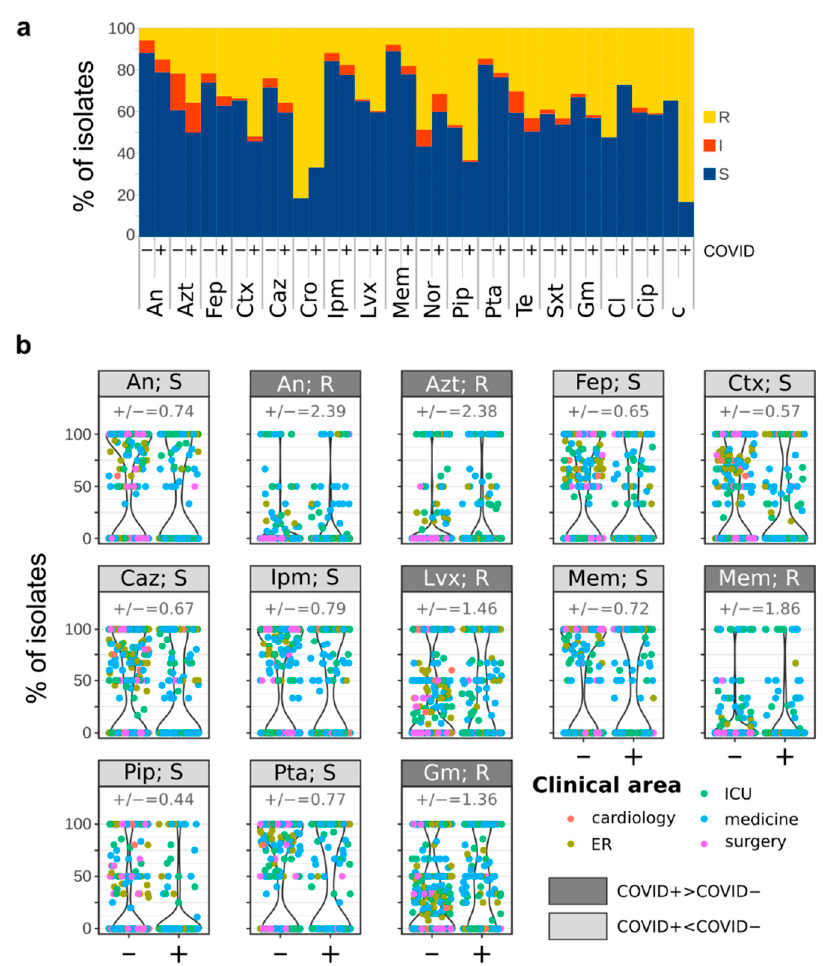
Figure 3. Distribution of antimicrobial resistances among COVID+ and COVID − patients. ( a ) percent- ages of isolates Resistant (R), Intermediate (I), and Susceptible (S) to the indicated antibiotics. ( b ) Vio- lin plots showing the responses to antibiotics significantly different between COVID+ and COVID − patients’ isolates (Wilcoxon-Mann-Whitney p < 0.05). “+/ − ” = ratio between the percentage of COVID+ and COVID − isolates showing the corresponding response to the antibiotic. An = amikacin, Azt = aztreonam, Fep = cefepime, Ctx = cefotaxime, Caz = ceftazidime, Cro = ceftriaxone, Ipm = imipenem, Lvx = levofloxacin, Mem = meropenem, Nor = norfloxacin, Pip = piperacillin, Pta = piperacillin-tazobactam, Te = tetracycline, Sxt = trimethoprim/sulfamethoxazole, Gm = gen- tamicin, Cl = colistin, Cip = ciprofloxacin, c =